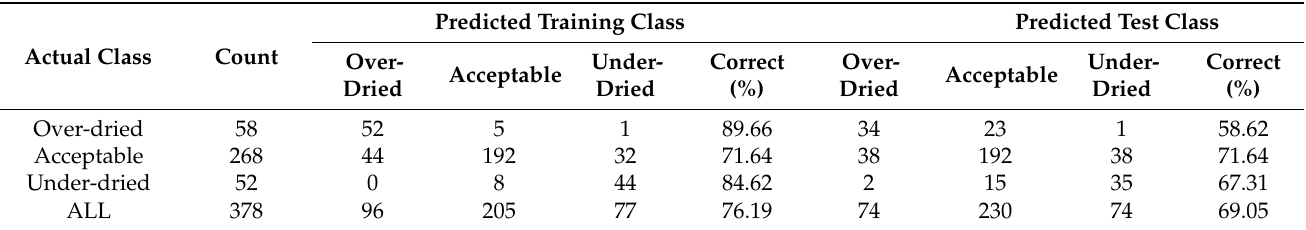
Table 8. Confusion matrix and the summary of the classification with a random forest model.